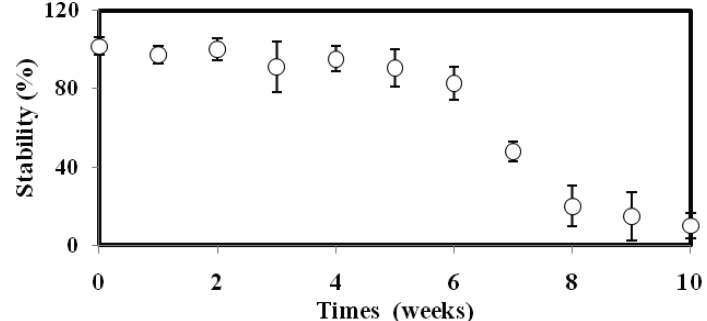
Figure 4. The stability of the biosensor for a testing period of 10